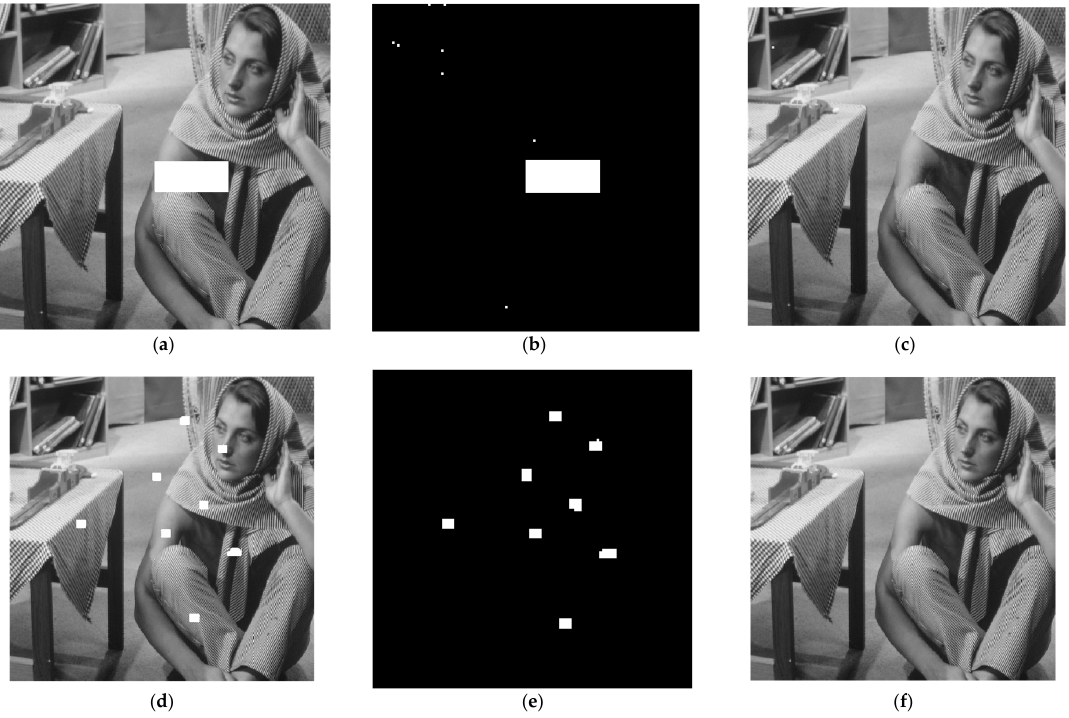
Figure 12. The visual performance for Barbara: ( a ) Cutting attack 1, ( b ) Detection of ( a ), ( c ) Recovery of ( a ), ( d ) Cutting attack 2, ( e ) Detection of ( d ), and ( f ) Recovery of ( d ). We further simulated two kinds of copy-paste attacks to measure the detection and recovery performance. The copy-paste attack copies the image blocks from one authenti- cated image and then inserts them into arbitrary positions in the watermarked image. Fig- ures 13 and 14 show the visual performance under copy-paste attacks for Airplane and Barbara, respectively. The tampering rates α are set to be 4.53% and 1.84% for copy-paste attack 1 and copy-paste attack 2, respectively. The simulation results show that the regions tampered with by the copy-paste attack can be sufficiently detected and recovered. ( f ) Figure 13. The visual performance for Airplane: ( a ) Copy-paste attack 1, ( b ) Detection of ( a ), ( c ) Recovery of ( a ), ( d ) Copy-paste attack 2, ( e ) Detection of ( d ), and ( f ) Recovery of ( d ).